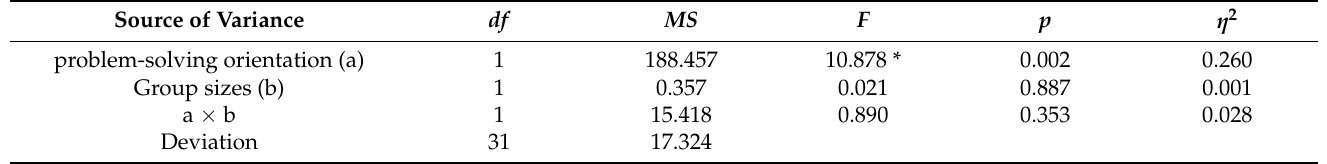
Table 2. Variance analysis of CPS scores under different problem-solving orientations and team